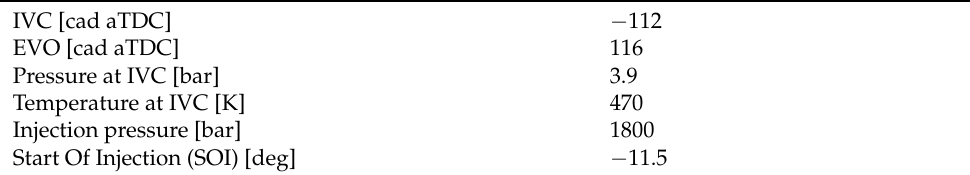
Table 3. CFD model boundary